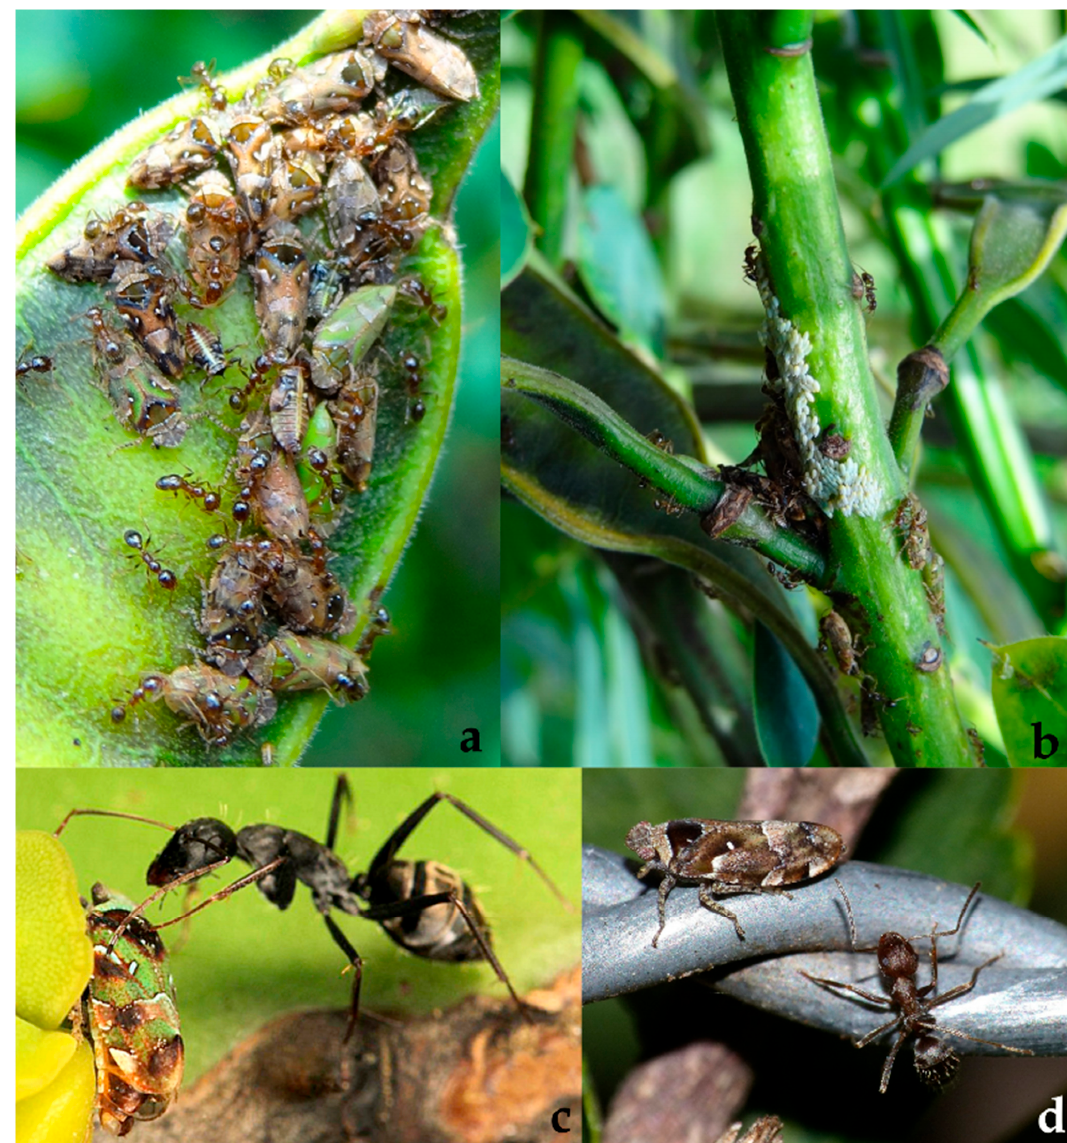
Figure 26. Tettigometridae: ( a , b ) Nototettigometra sp. near N. ( N. ) patruelis tended by Formicidae undet., Kenya, Masai Mara, on Senna didymobotrya (Fresen.) Irwin and Barneby (Fabaceae), 24.10.2013, obs. T. Bourgoin; ( c ) Nototettigometra sp. tended by Formicidae: Formicinae: Camponotus sp., South Africa: Timbavati Nature Reserve, 24°22 ′ 34.9 ″ S 31°09 ′ 40.4 ″ E, 21.05.2014, eggs and adults on Euphorbia sp. (Euphorbiaceae), obs. W. Uys; ( d ) Nototettigometra sp. tended by Formicidae: Formicinae undet., South Africa: South Cape, 33°58 ′ 00.3 ″ S 22°05 ′ 26.5 ″ E, 21.04.2019, adults, obs. S. Adam.